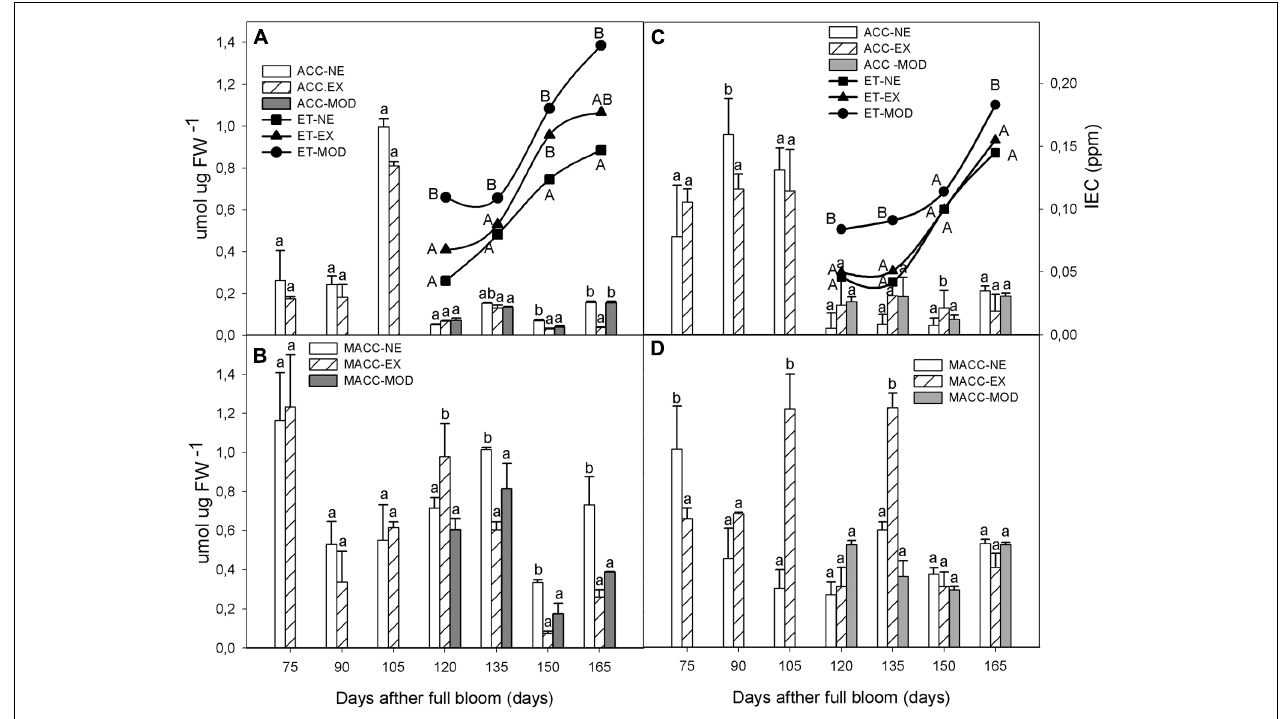
FIGURE 1 | Internal ethylene concentration (ET), free ACC and Malonyl-ACC (MACC) interactions in apple skin during fruit development of non-exposed (NE), exposed (EX), and moderate sun-damaged (MOD) fruit from orchards Quilpue (A,B) and Los Lirios (C,D) , Maule Region, Chile. Different upper-case (ET) and lower-case (ACC and MACC) letters indicate statistical difference ( P ≤ 0.05) between sun damage levels at each time point. Values represent means ± SE of 3 biological